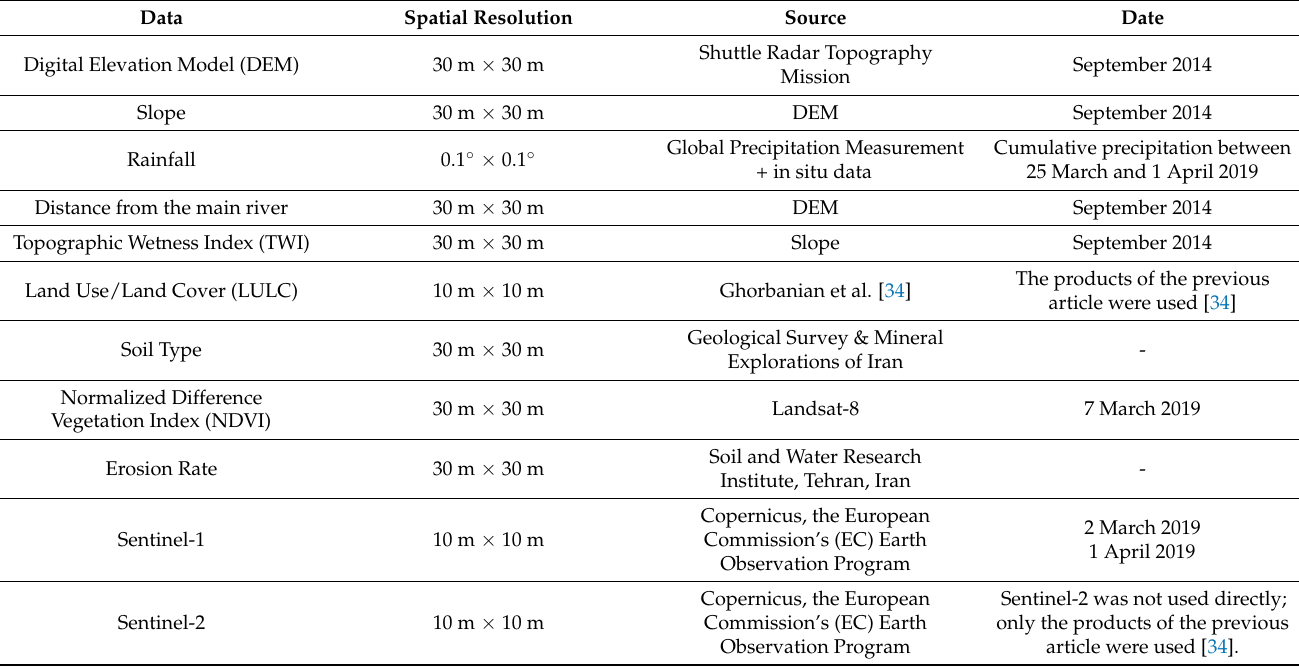
Table 1. Overview of the specifications of the nine parameters used for flood hazard mapping.